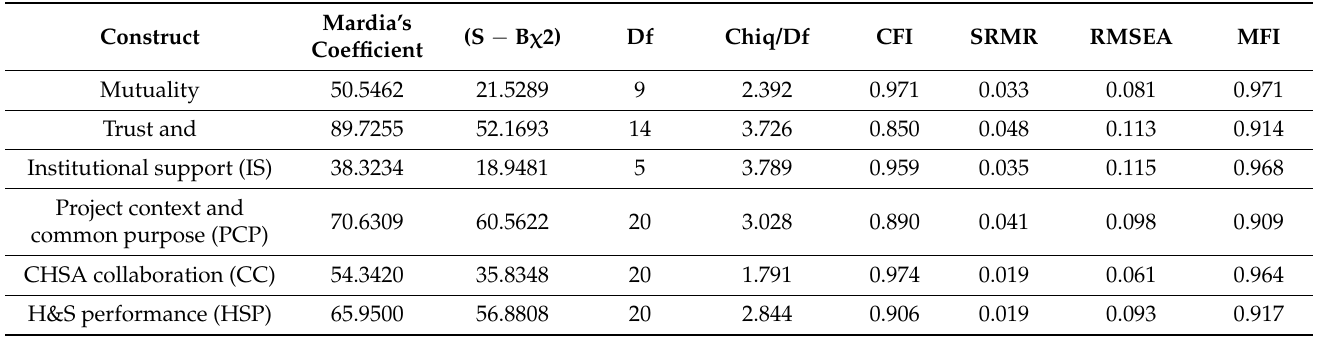
Table 10. Measurement model statistics on distribution and fit.